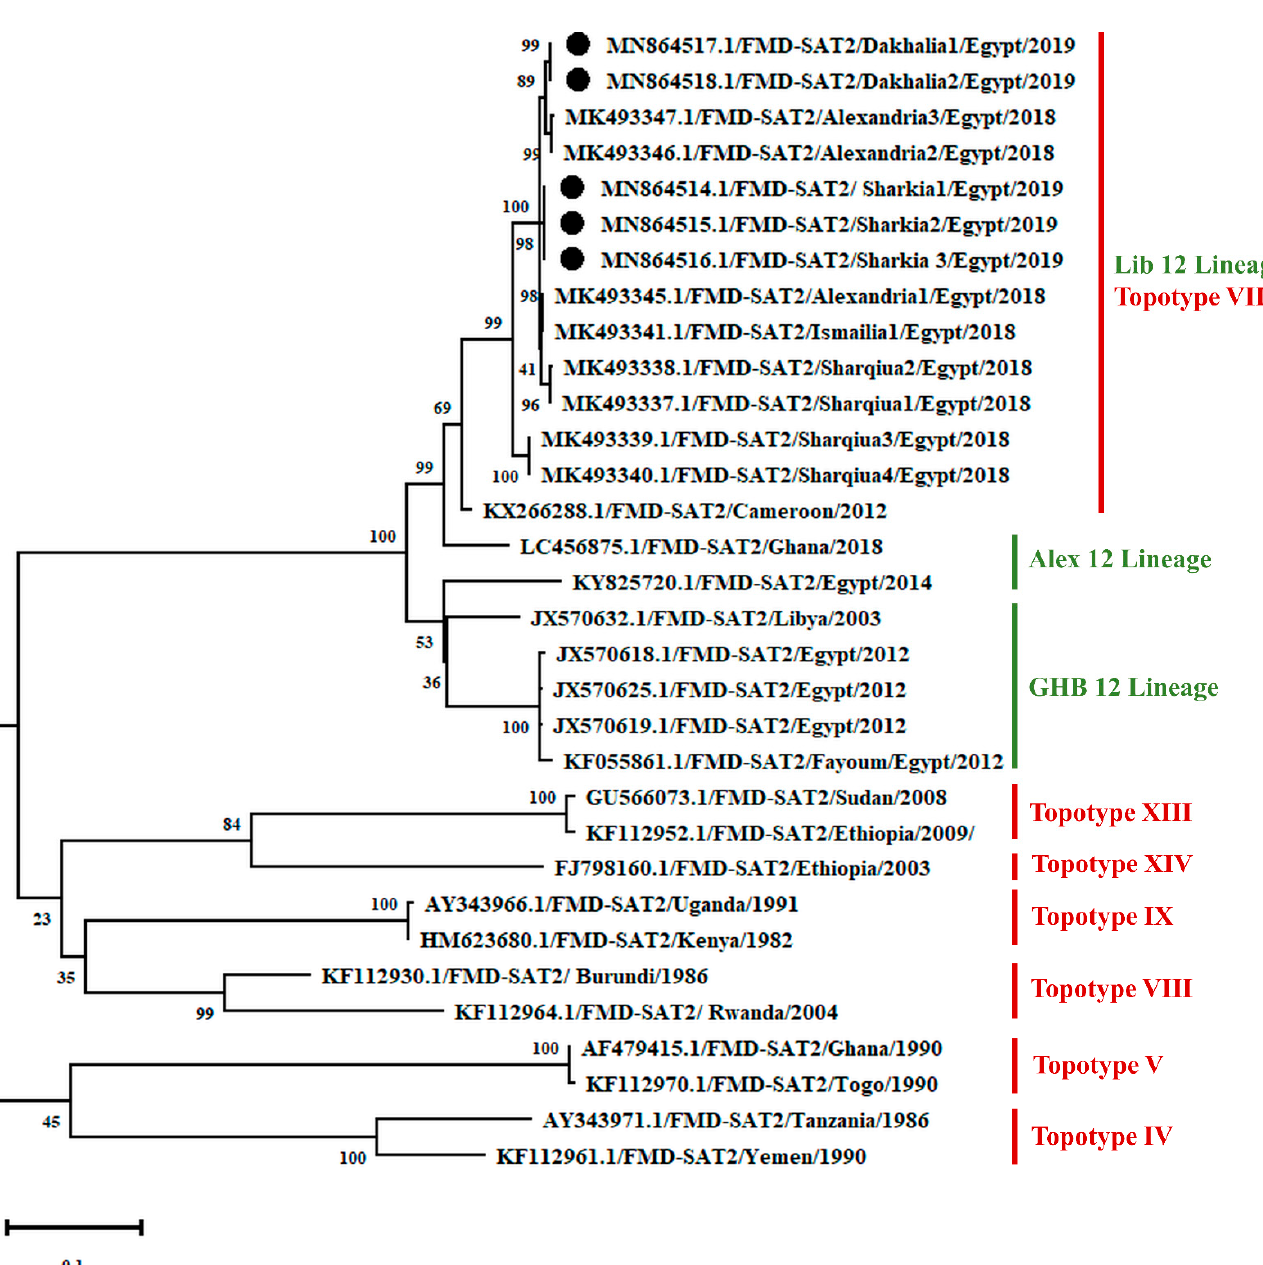
Figure 1. Phylogenetic analysis of the VP1-coding sequences showing the relation between different FMD SAT-2 of various topotypes. The tree was constructed using the Hasegawa–Kishino–Yano model as a maximum likelihood method and a discrete Gamma distribution (+G) with five rate categories and assuming that a certain fraction of sites are evolutionarily invariable (+I) at 1000 bootstraps. The black colour circles refer to the FMD isolates recovered in the present study.